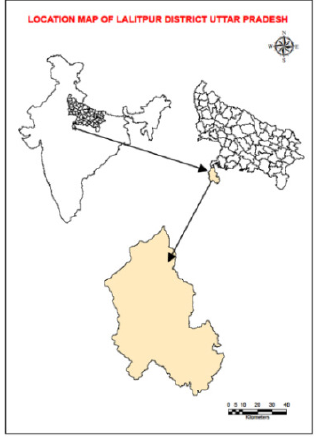
Figure 1: Location Map of Study area Lalitpur is one of the district of Bundelkhand region of Uttar Pradesh province of India. It lies between Latitude 24 0 11’N to 24 0 14’ N and Longitude be 78 0 8’ E and 79 0 0’ E. what's more, is limited by locale Jhansi in the north, Sagar and Tikamgarh districts of Madhya Pradesh state in the east and Guna district of Madhya Pradesh isolated by stream Betwa in the west. The district encompasses around 5,039sq km area (Figure: 1). The data sets which were used in this study are given in Table